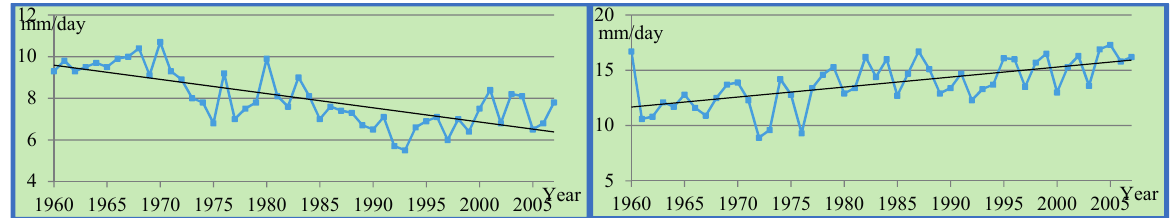
Figure 14. The most significant negative trend with a slope of − 6.3959 ( left ) and the most significant positive trend with a slope of 7.3096 ( right ) of the R99p index.